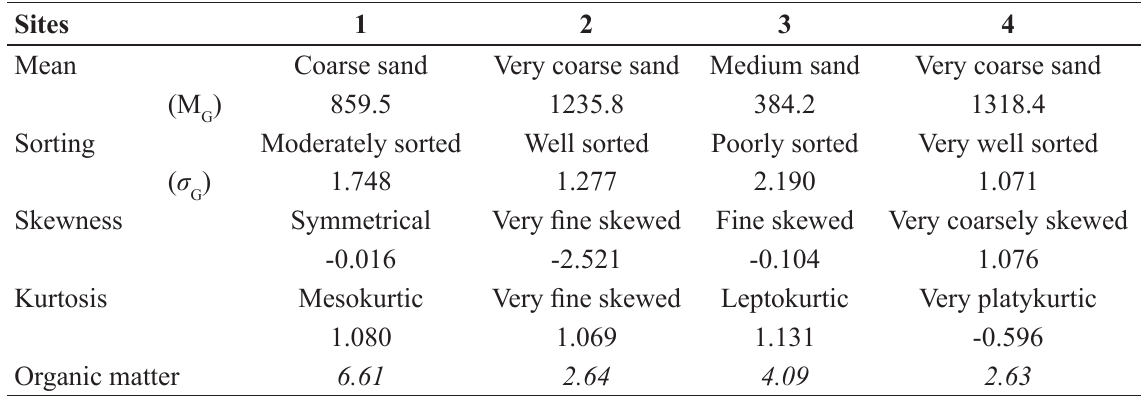
Table 1. Main results of sediment sample granulometric analyses. All measurements are given in micrometres (μm); indicators are given as a percentage (%) and